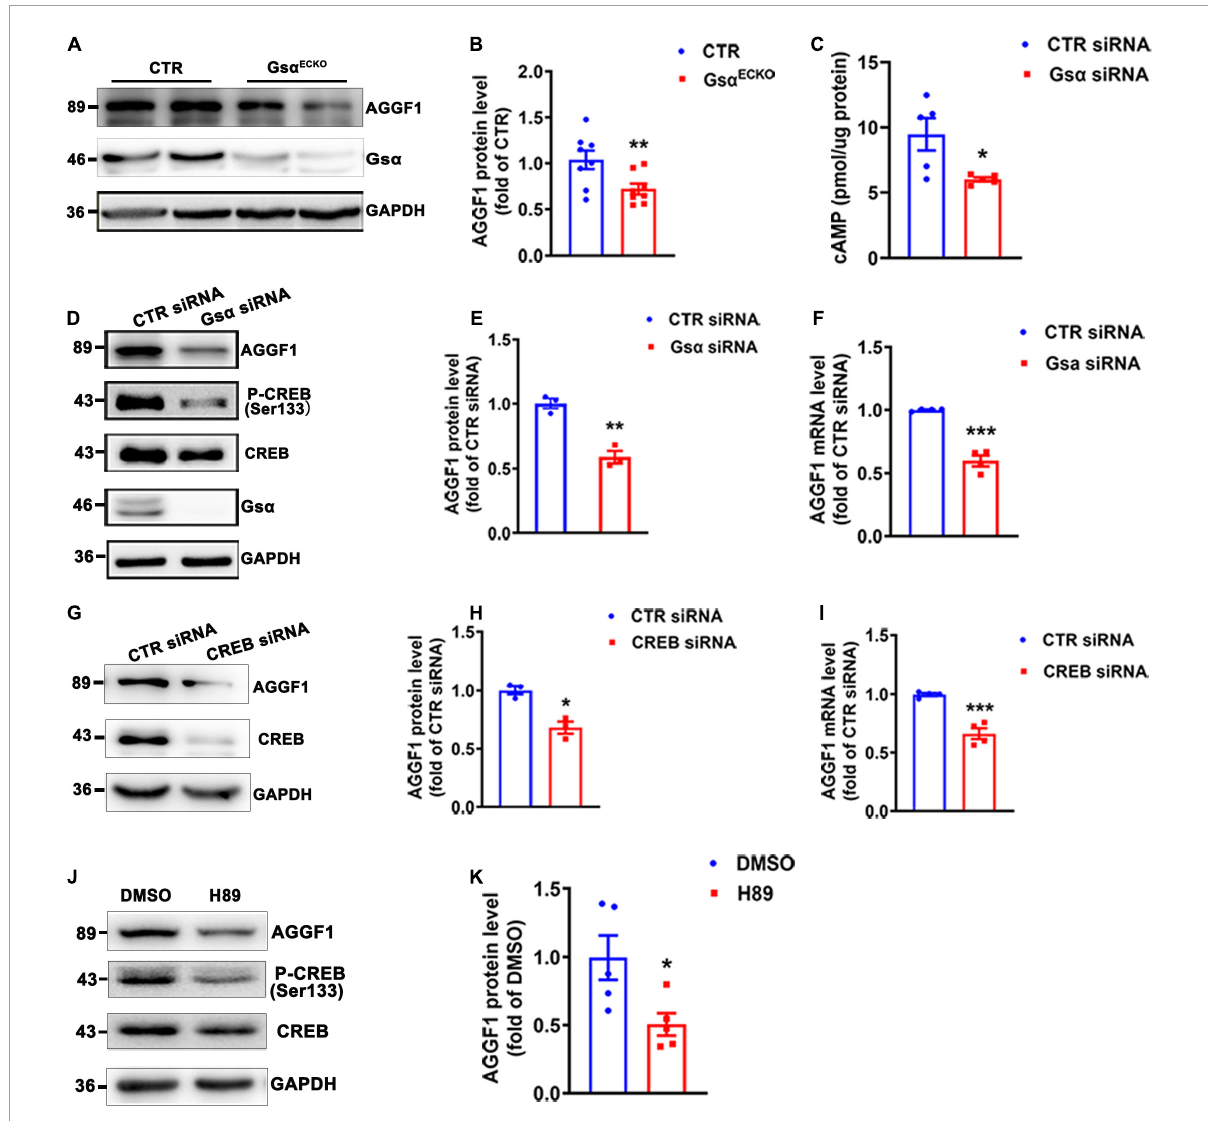
FIGURE4 Gs α deficiency decreases AGGF1 expression. (A,B) Western blot analysis and quantification of AGGF1 protein levels lung tissues from CTR and Gs α ECKO mice. n = 8/group. (C) cAMP level was measured in HUVECs transfected with CTR siRNA or Gs α siRNA. n = 5/group. (D,E) Western blot analysis and quantification of AGGF1 in HUVECs transfected with CTR siRNA or Gs α siRNA. n = 3/group. (F) RT-qPCR analysis of AGGF1 mRNA level in HUVECs transfected with CTR siRNA or Gs α siRNA. n = 4/group. (G,H) Western blot analysis and quantification of AGGF1 in HUVECs transfected with CTR or CREB siRNA. n = 3/group. (I) RT - qPCR analysis of AGGF1 mRNA level in HUVECs transfected with CTR or CREB siRNA. n = 4/group. (J,K) Western blot analysis and quantification of AGGF1 in HUVECs treated with DMSO or H89 (10 µ M) for 24 h. n = 5/group, * P < 0.05, ** P < 0.01, *** P < 0.001 vs. DMSO (unpaired Student’s t -test). Data are mean ± SEM.